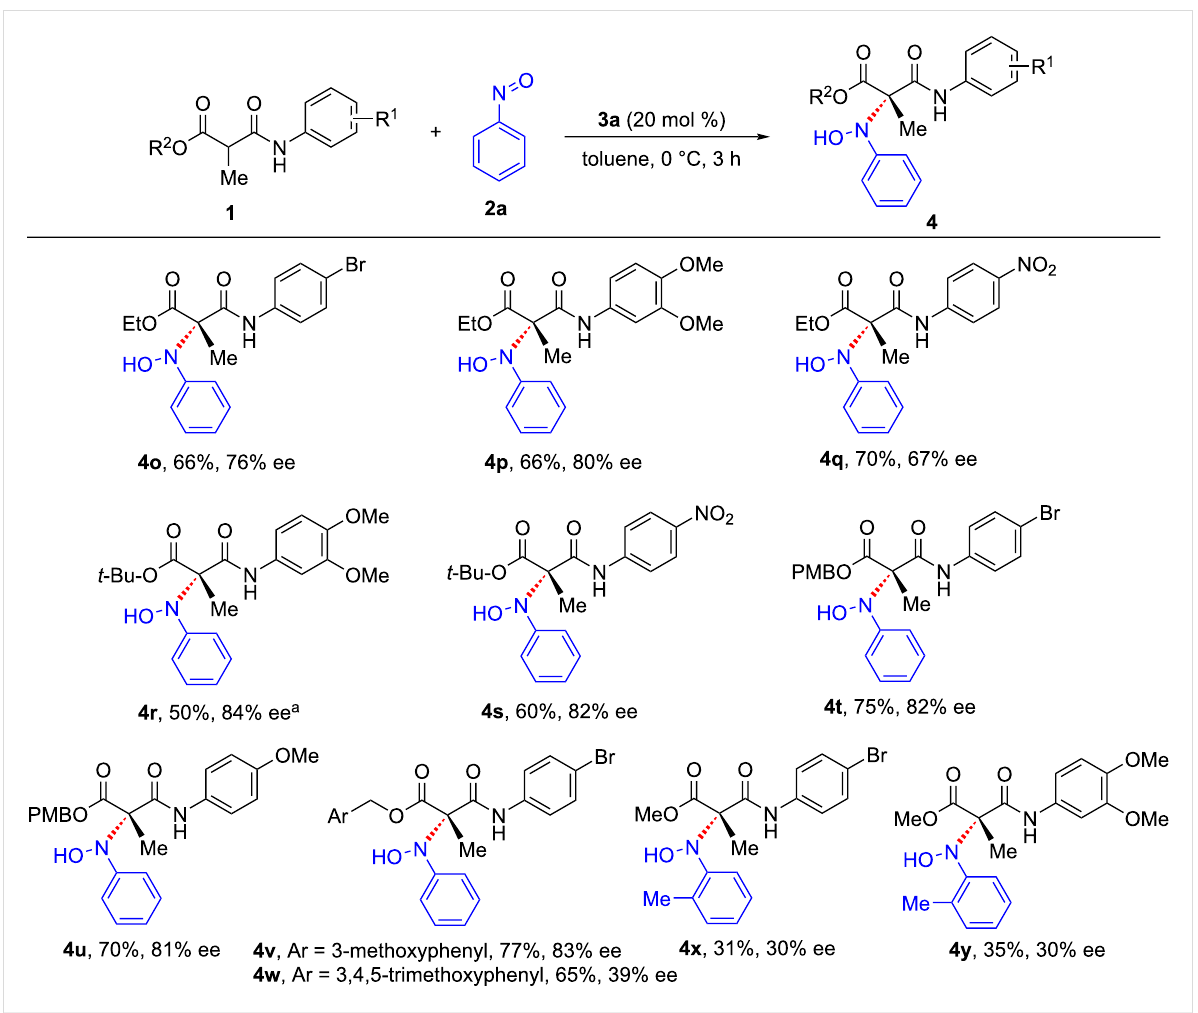
Scheme 3: Variation of ester moiety of malonamates and nitrosoarenes. General conditions: 1 (0.20 mmol), 2a (0.24 mmol), 3a (0.04 mmol), toluene (3.0 mL). Yields refer to isolated yields after silica gel column chromatography. Enantioselectivities were determined by chiral HPLC analysis. a Reaction run for 6 h.